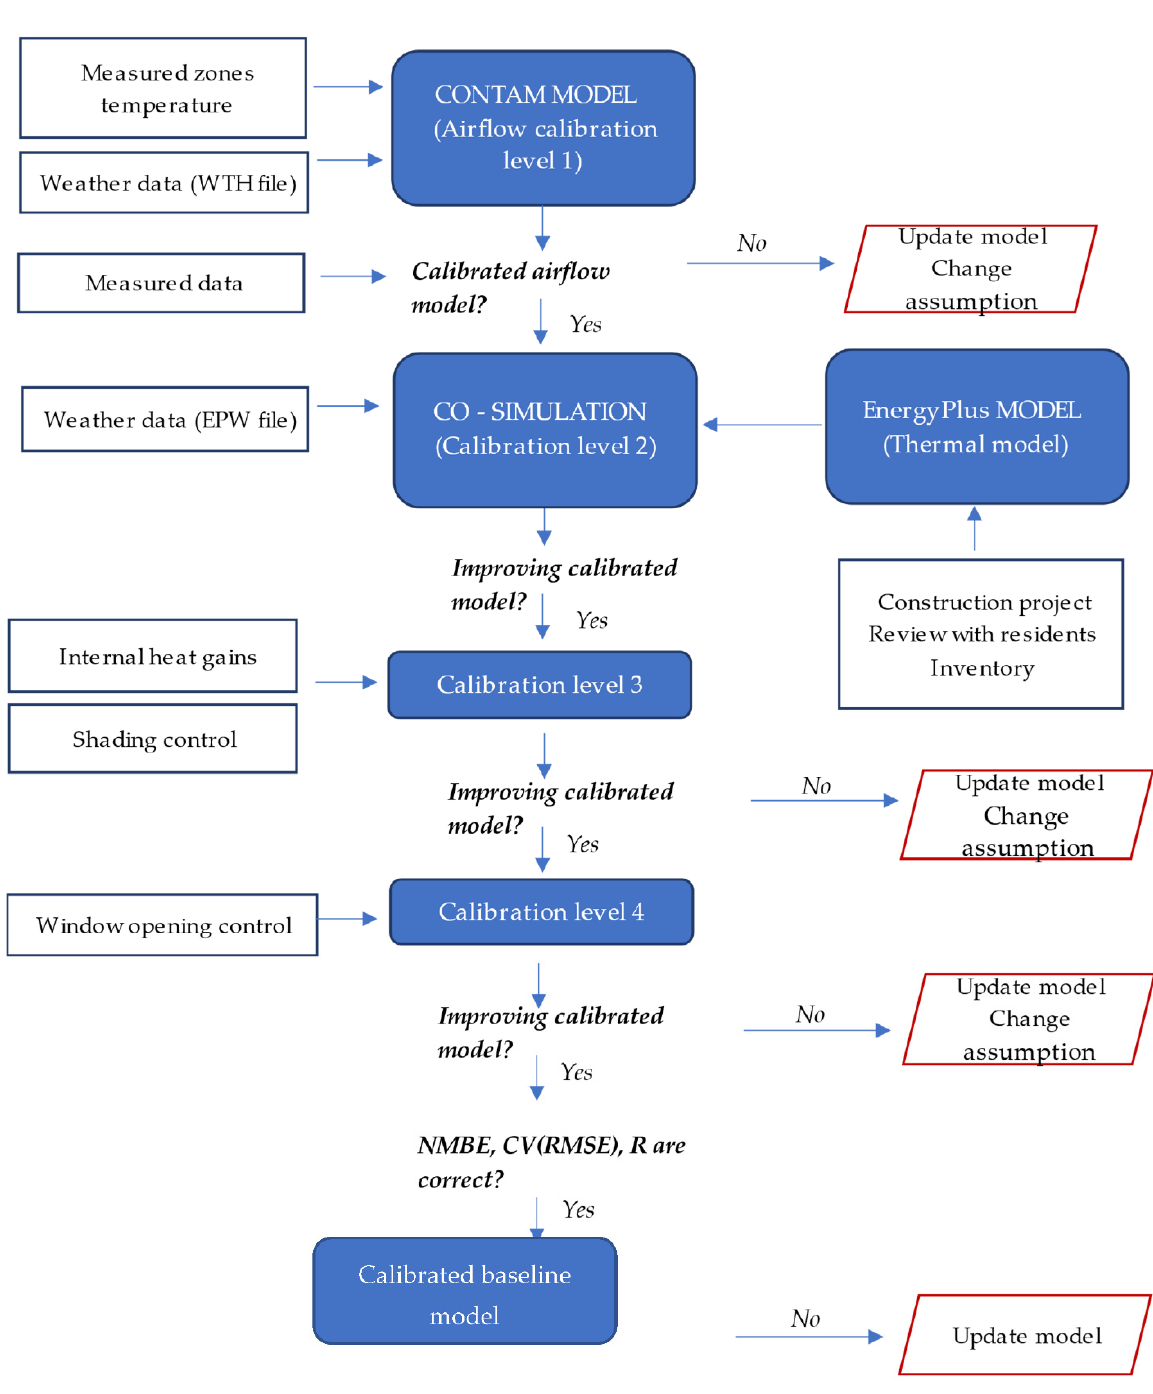
Figure 5. Scheme of the calibration process.